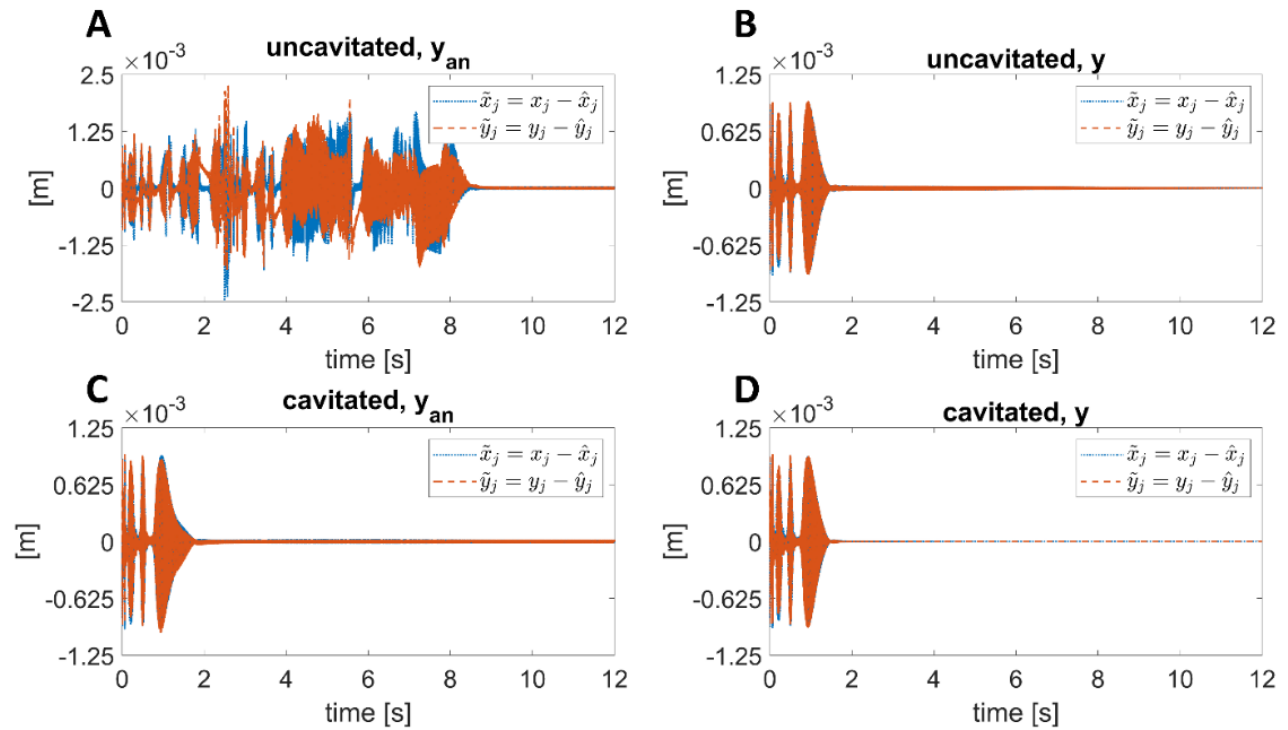
Figure 10. Observation errors of the journal displacement coordinate (cid:101) z j with analytical output noise for uncavitated and cavitated conditions ( A , C ) and with measured output noise for uncavitated and cavitated conditions ( B , D ).